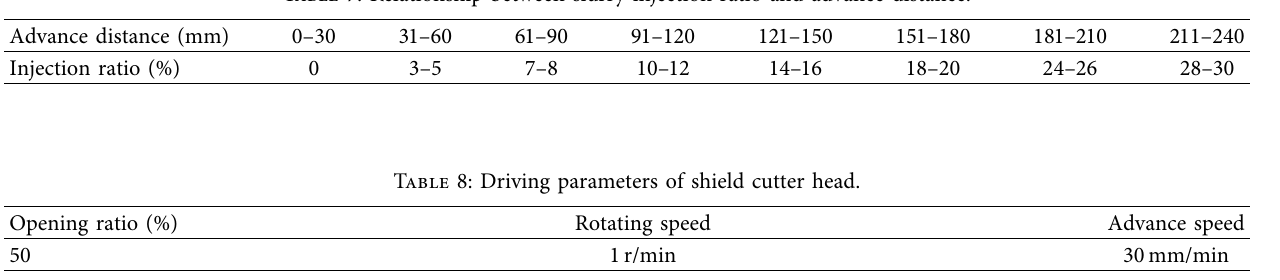
Table 7: Relationship between slurry injection ratio and advance distance.